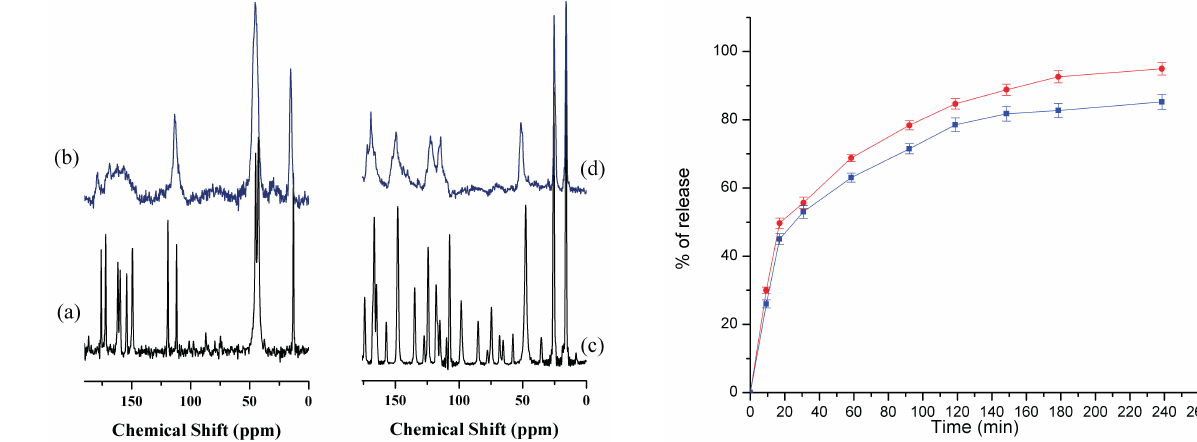
Figure 7: Release profile of NAD from LDH-CO from LDH-CO -PIP (-●-) in 50 mM phosphate buffer at pH 7.5. The -NAD. 3 3 amount of NAD or PIP was monitored by UV-vis